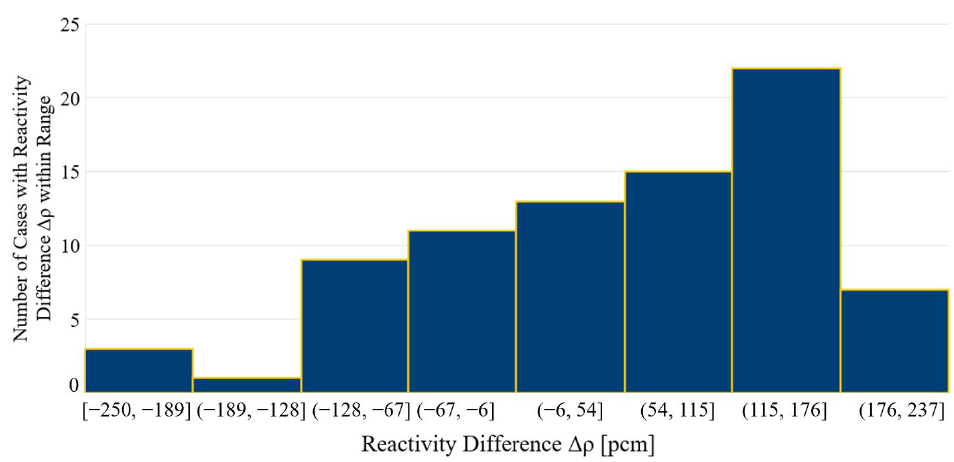
Figure 14. Histogram of reactivity difference for single 2-D assembly problems.